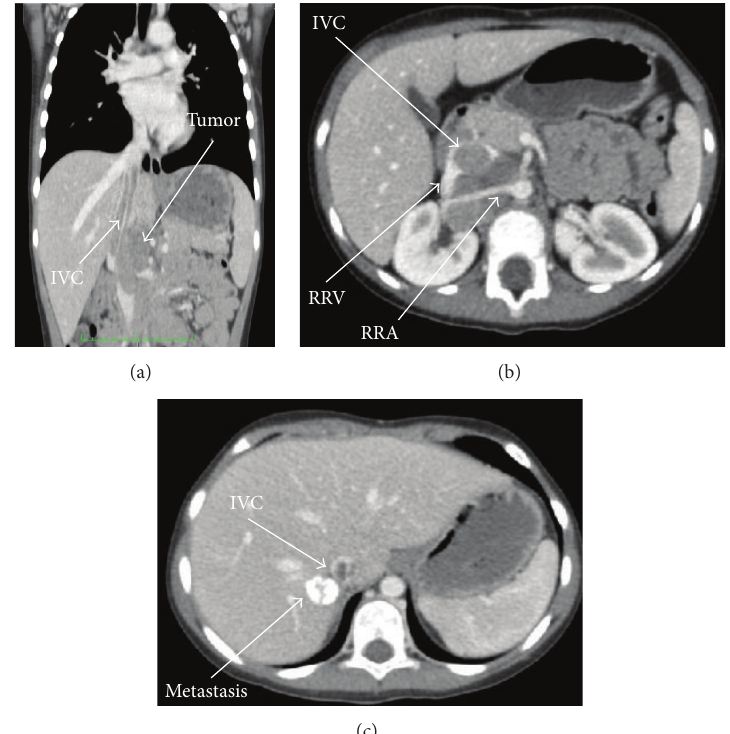
Figure 1: Computed tomographic scanning showing (a) incomplete obstruction of inferior vena cava (IVC) by tumor mass (b) incorporating the right renal artery (RRA) and the right renal vein (RRV). Abdominal imaging revealed a calcified solitary hepatic lesion